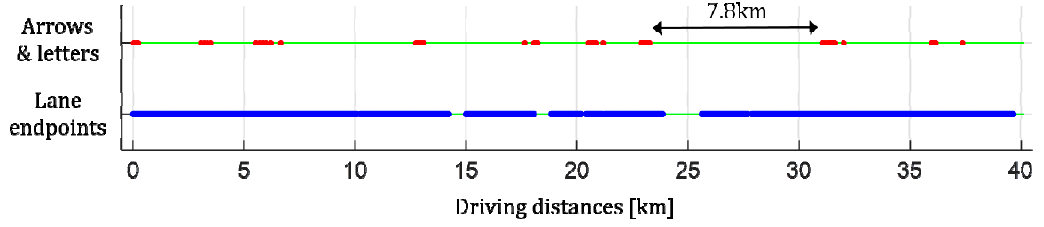
Figure 1. Analysis of distributions of road markings in highway situations.